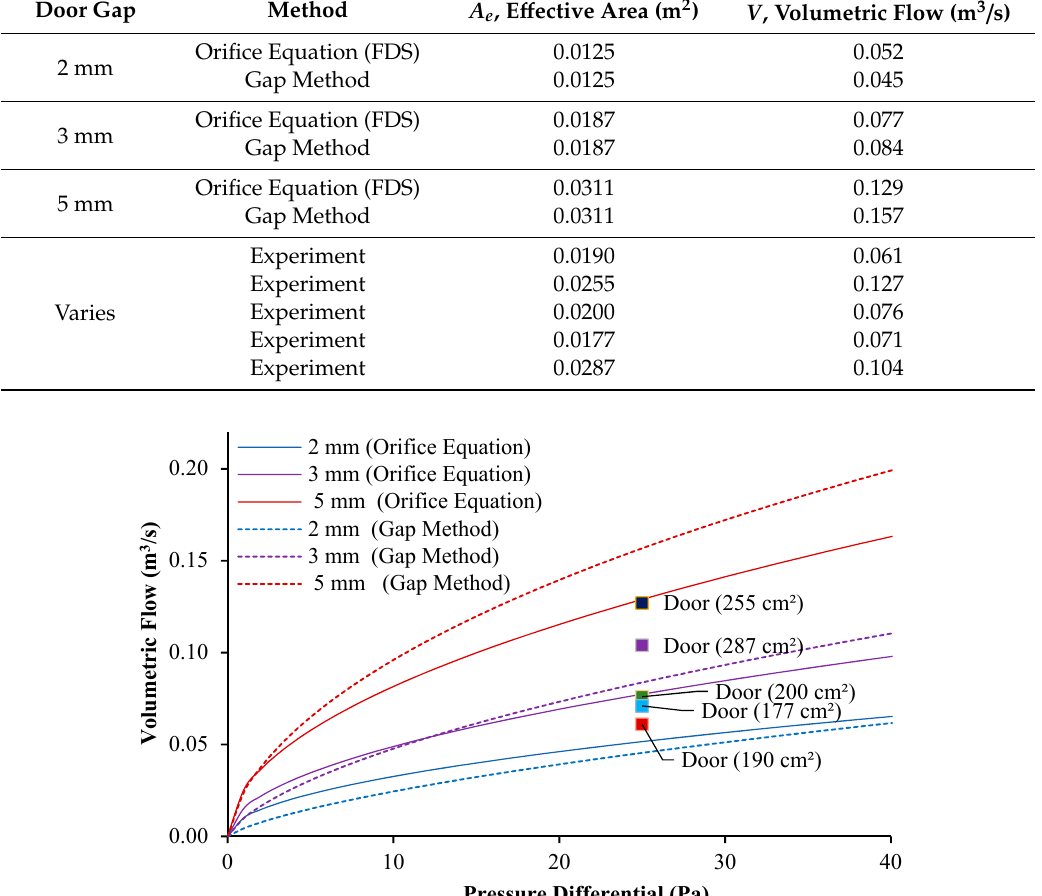
Table 2. Comparison of leakage area and volumetric airflow for closed doors, using the orifice equation, gap method, and experimental measurements with a 25 Pa pressure differential.